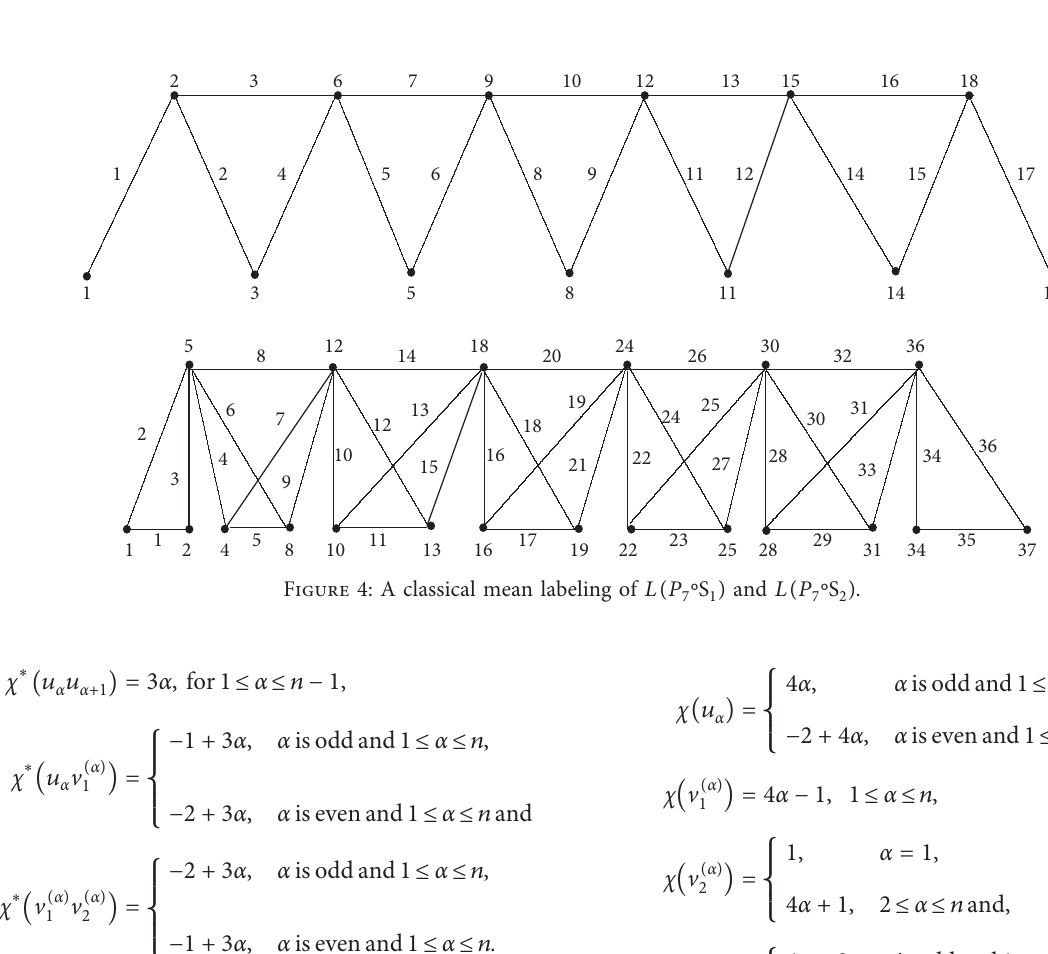
S and P S 7 ° 1 7 ° 2